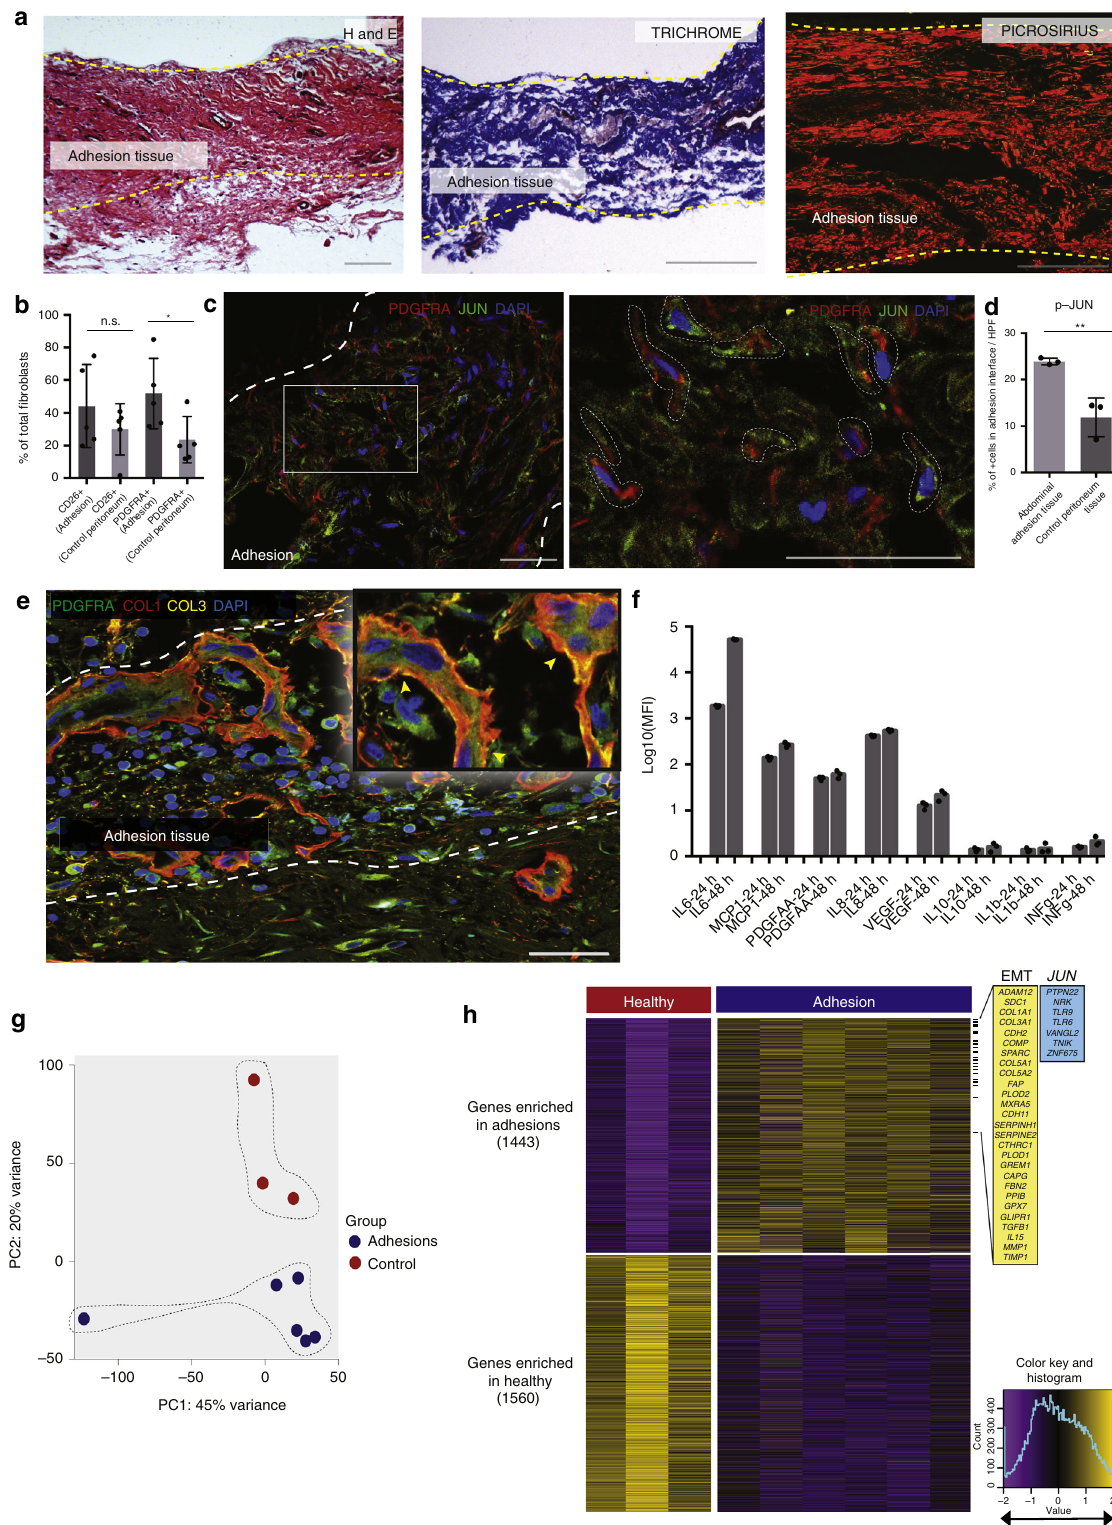
Fig. 18a). Other signi fi cant gene sets associated with